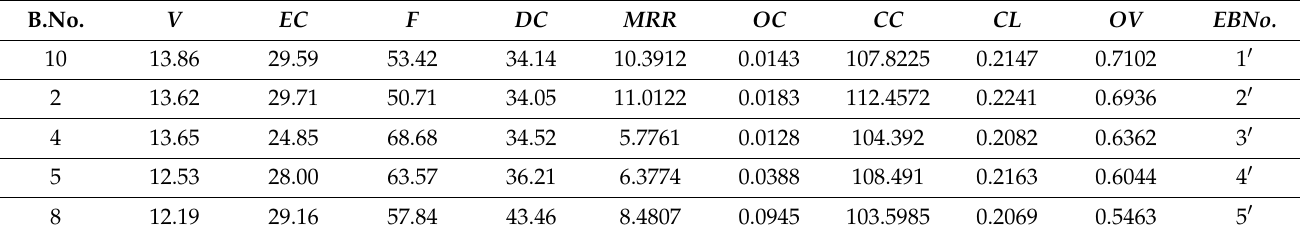
Table A6. Employed bees.